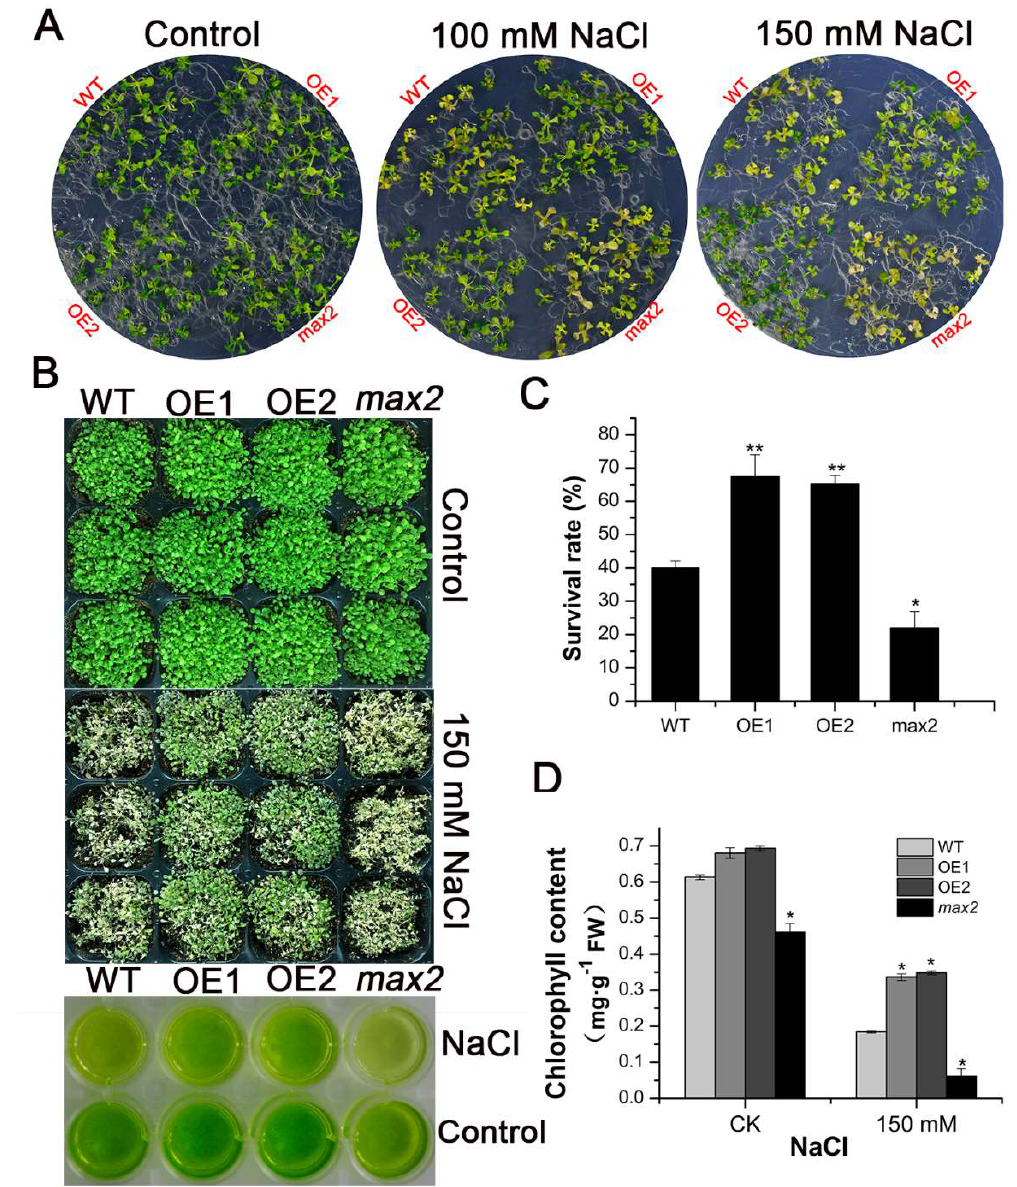
Figure 5. SsMAX2 conferred salt resistance in Arabidopsis . ( A ) Growth phenotype of 5-day-old SsMAX2 OE lines, max2 , and WT seedlings under salt stress; ( B , C ) The growth and survival rate 7 days after 150 mM NaCl treatment on 15-day-old seedlings; ( D ) Chlorophyll content of the seedling leaves before or 7 days after salt stress treatment. Data are presented as means ± SD of three biological replicates. Significant differences between WT and the other groups were determined by Student’s t -test. Significance level: * p < 0.05, ** p < 0.01.